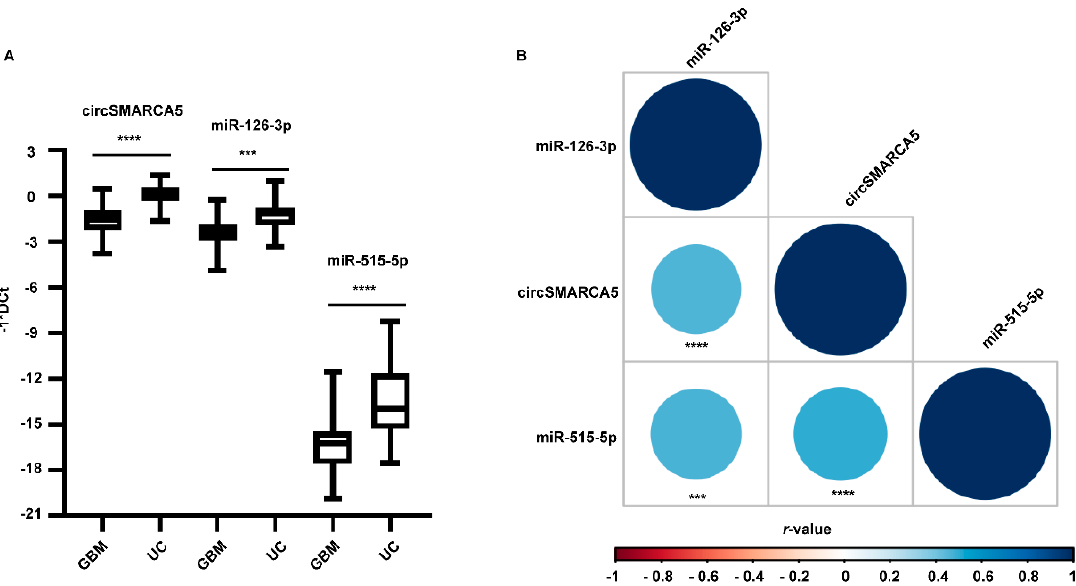
Figure 3. CircSMARCA5, miR-126-3p, and miR-515-5p are downregulated and positively correlated in GBM and UC biopsies. ( A ) Box and whisker plots representing the expression of circSMARCA5, miR-126-3p, and miR-515-5p in GBM and UC biopsies. Data are reported as − 1*DCt. Statistical significance is indicated as p -value under the name of each transcript. ( B ) Correlogram showing correlations among circSMARCA5, miR-126-3p, and miR-515-5p. The colour of the circle is linked to the type of correlation (colours from light blue to dark blue and from light red to dark red are representative of positive and negative correlation, respectively); the size of the circle is inversely proportional to the p -value (the bigger is the circle, the less is the p -value). The r -values have been calculated by applying Spearman’s correlation test (*** p -value < 0.001, **** p -value <